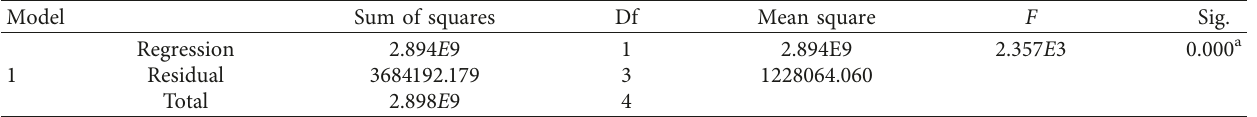
Table 2: Results of ANOVA analysis for calibration curve of MCI.